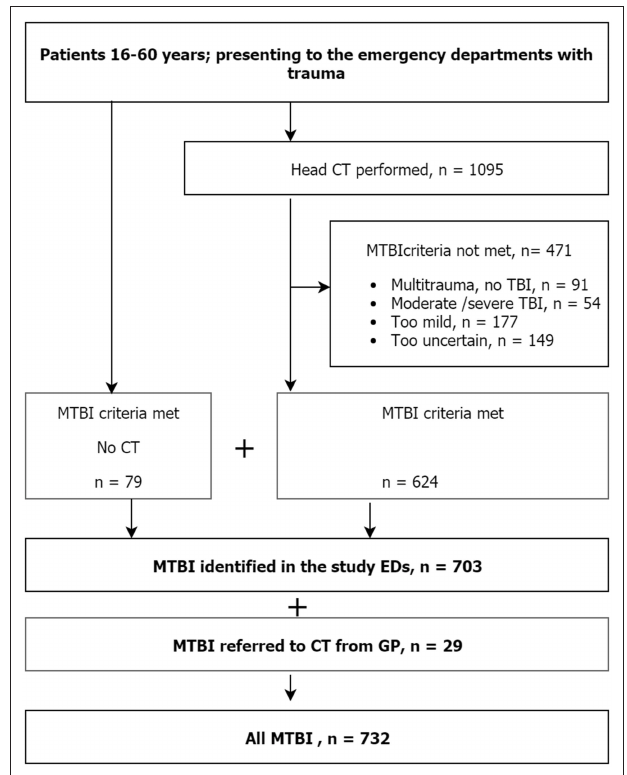
TABLE 1 | Mild traumatic brain injury (MTBI) incidence by age and